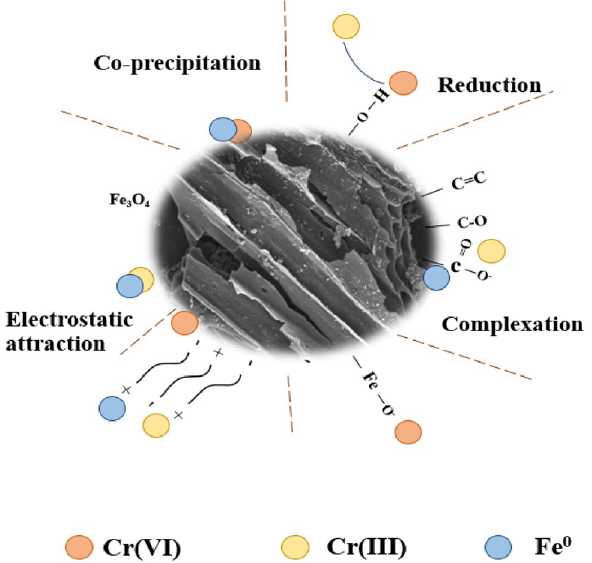
Figure 7. Adsorption mechanism of Cr(VI) by IMC.